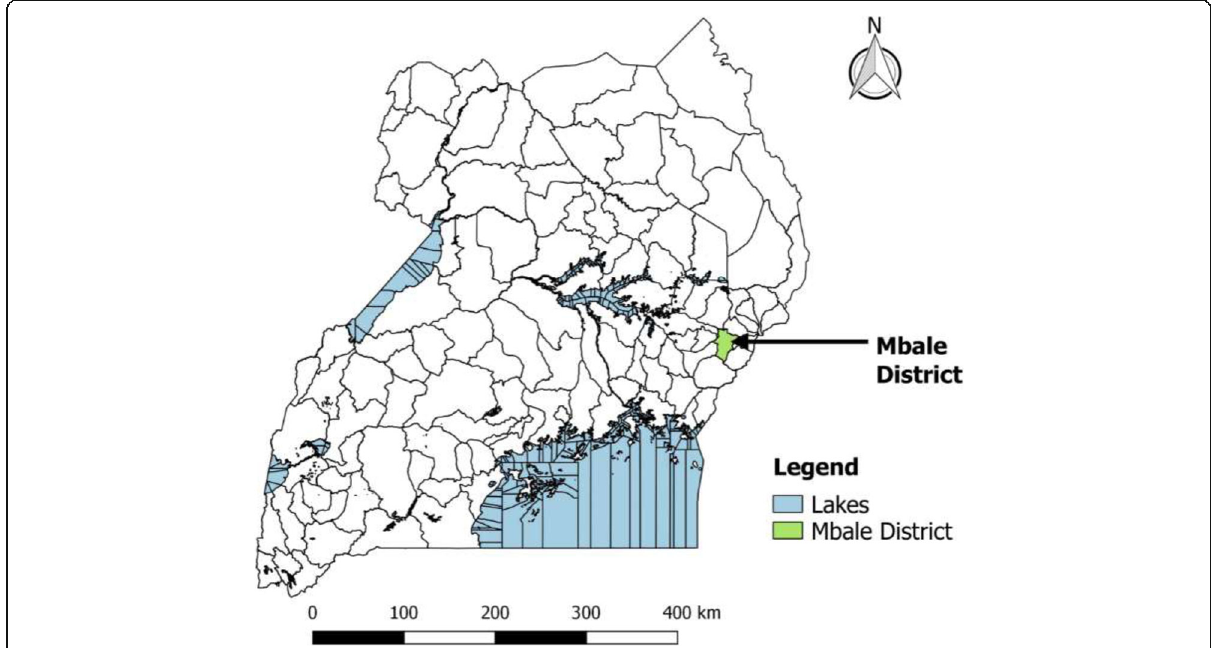
Fig. 1 Map of Uganda showing location of Mbale District (shaded) in Eastern